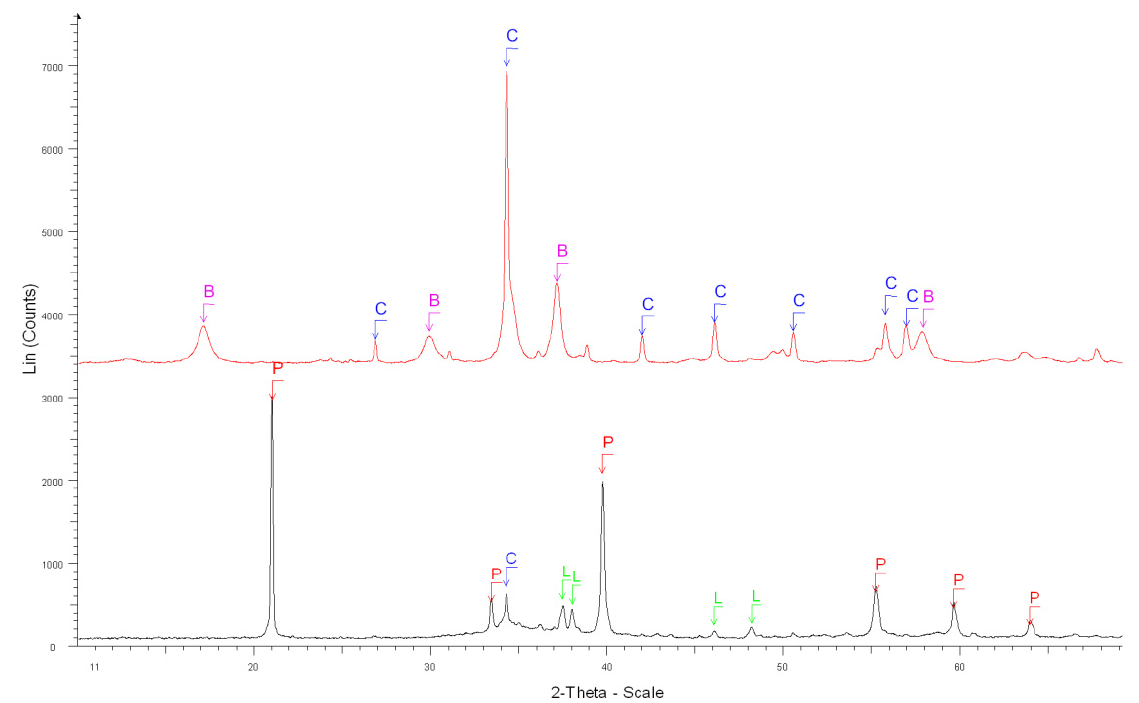
Figure 4. XRD diffractograms: Before (black curve below) and after the dissolution (red curve above) of white cement paste. B, C, P and L stand for brownmillerite, calcite, portlandite and β -dicalcium silicate, respectively.